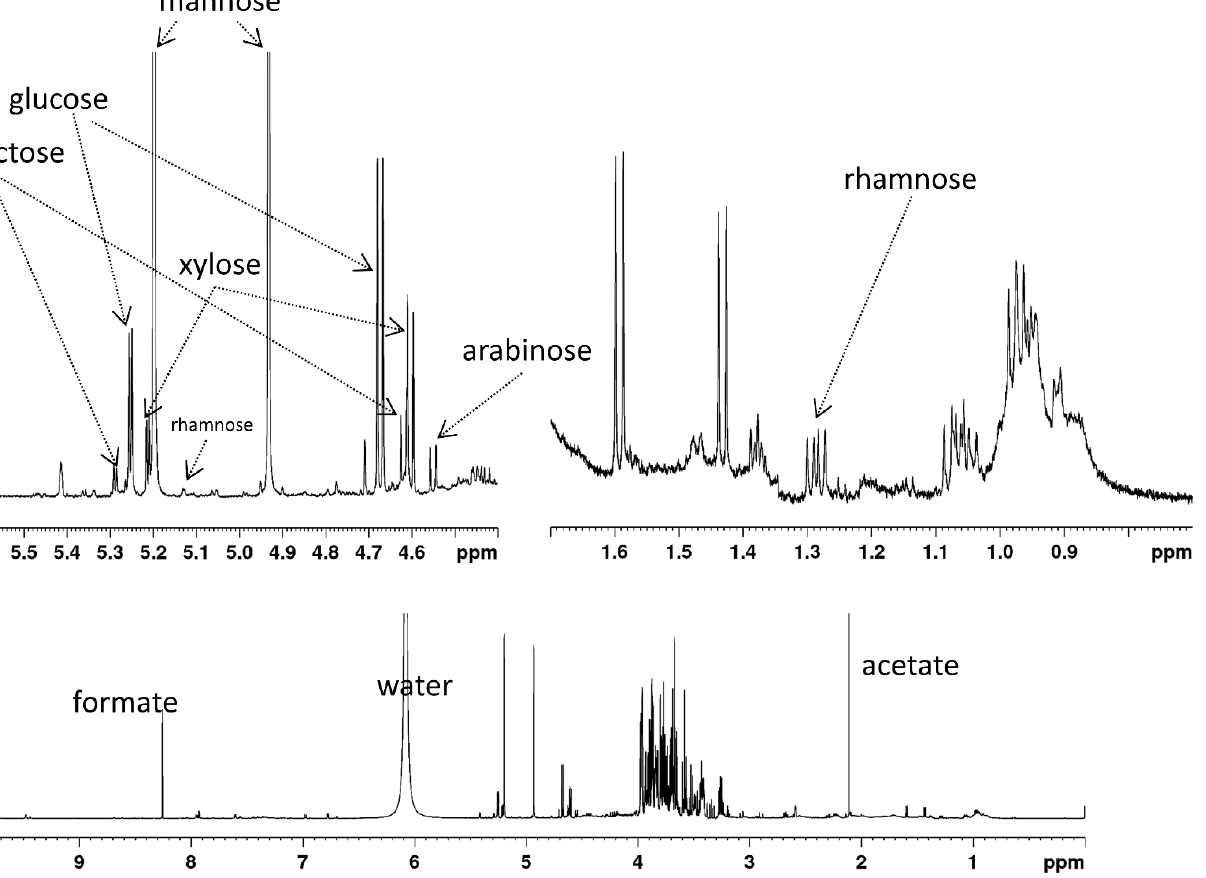
Figure 1. 1 H-NMR spectrum of acid-hydrolyzed PKC, recorded at 280 K in 10% D 2 SO 4 in D 2 O. The lower panel shows the complete spectrum, the upper left panel shows a zoom of the region displaying the resonances of the anomeric hydrogen atoms, the upper right panel shows a zoom of the methyl group region. The monosaccharide content is comparable to that found by Cervero et al. [22], who found 17.1% of mannose ( w / w of total PKC) and 3.9% of glucose and did not report any other monosaccharides. Düsterhöft et al. [9] also report small amounts of galactose, xylose, arabinose and rhamnose in